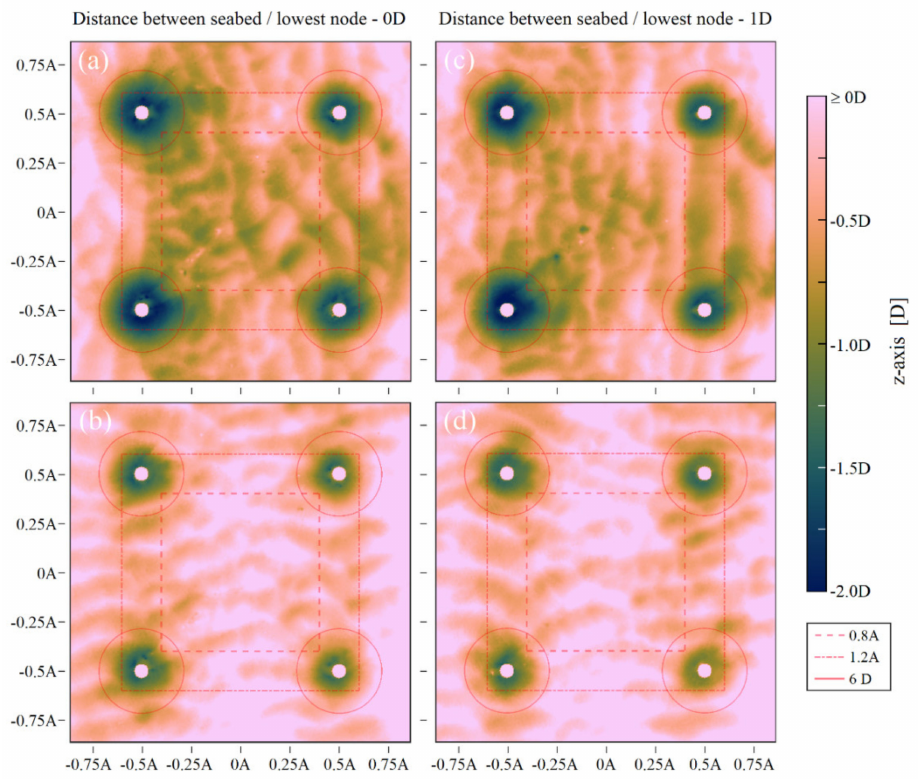
Figure 7. Surface elevation in top view of Test 3, 0D ( a ) and Test 5, 0D ( b ), compared with Test 3, 1D ( c ) and Test 5, 1D ( d ) under the same hydrodynamic conditions. The x - and y -axis distances are given in a dimensionless value A in relation to the structure footprint reference distance (D = 4